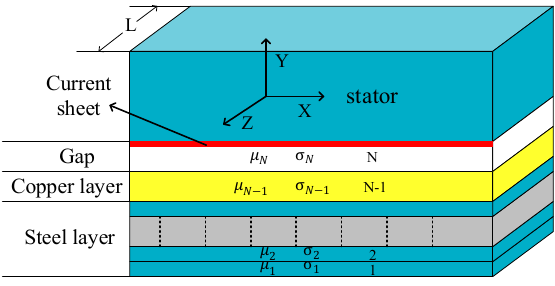
Figure 6. Multilayer model of the N-TWSRIM.